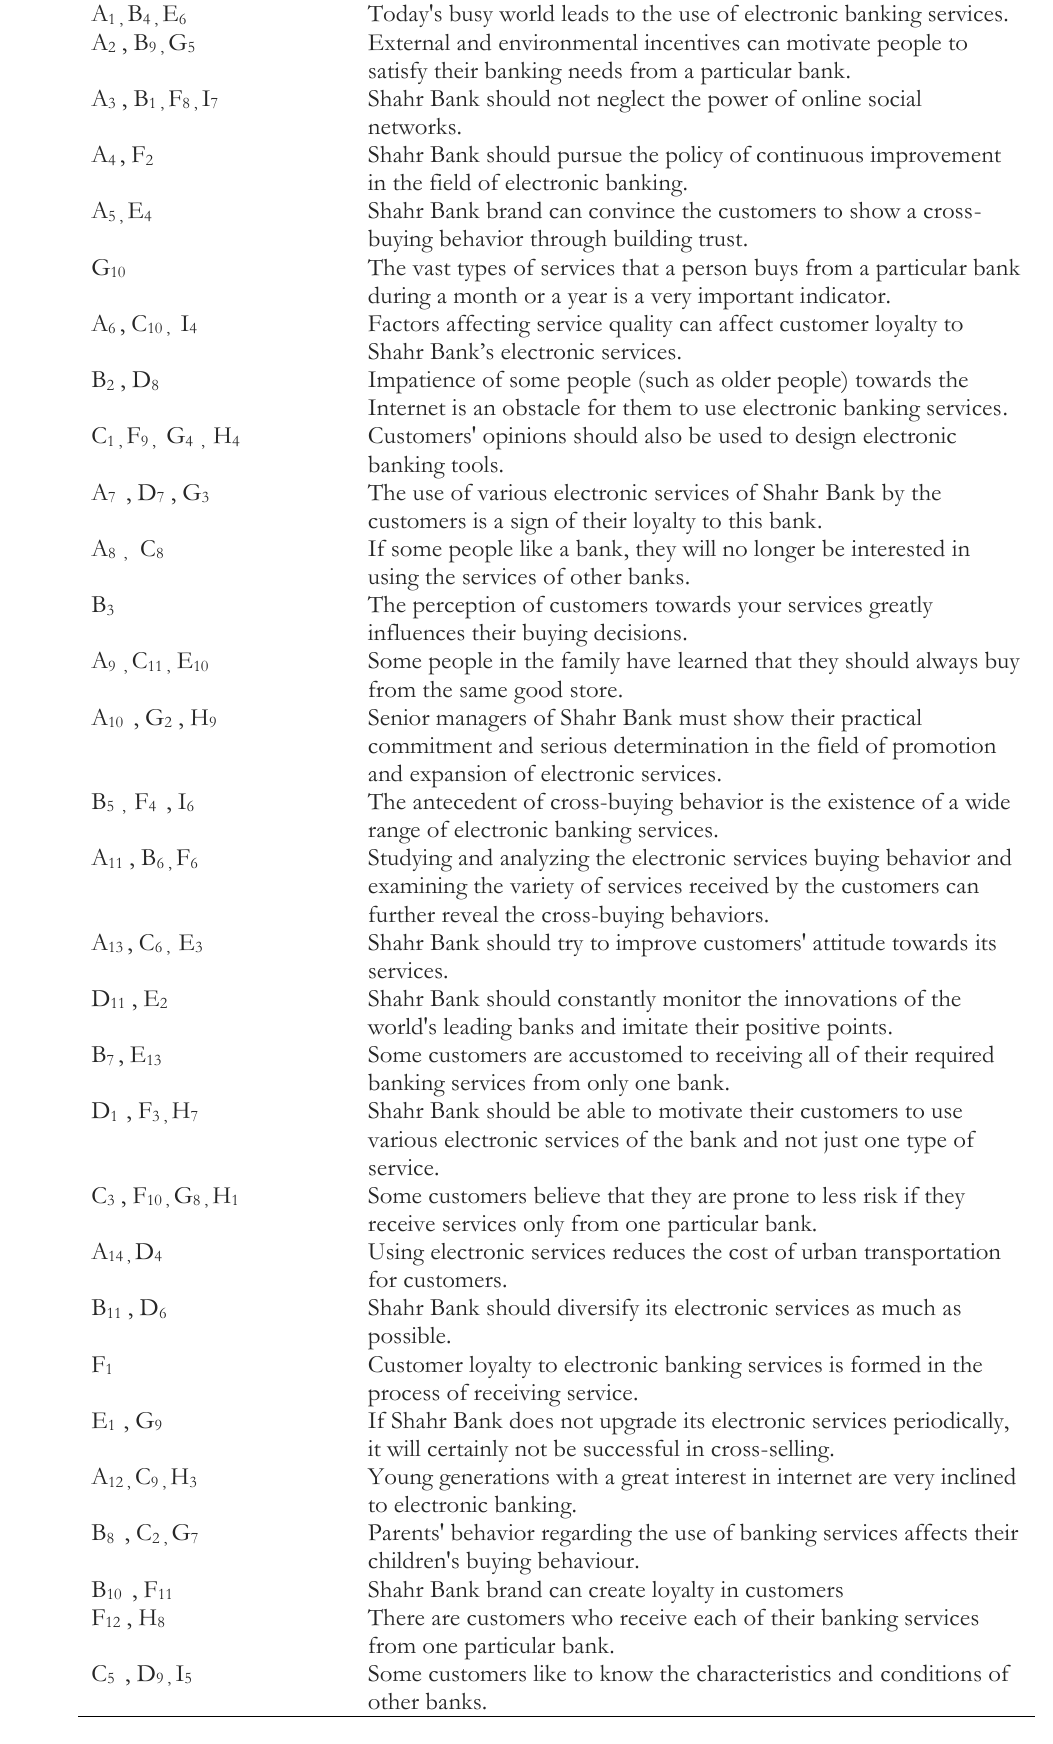
Table 1. Finalized concepts after analyzing the interviews and removing duplicate items in the open coding